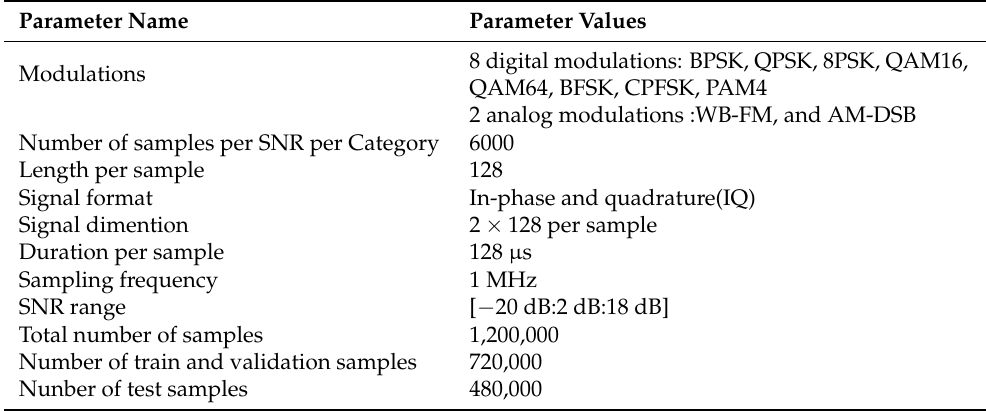
Table 1. RadioML2016.10b Dataset